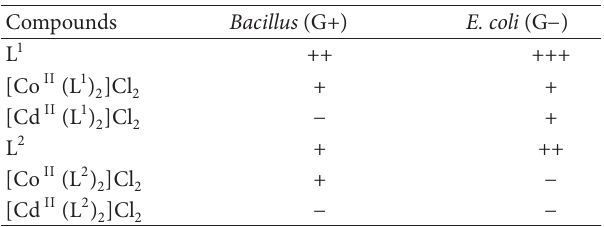
Table 4: Antibacterial activities of the synthesised Schiff-bases and metal